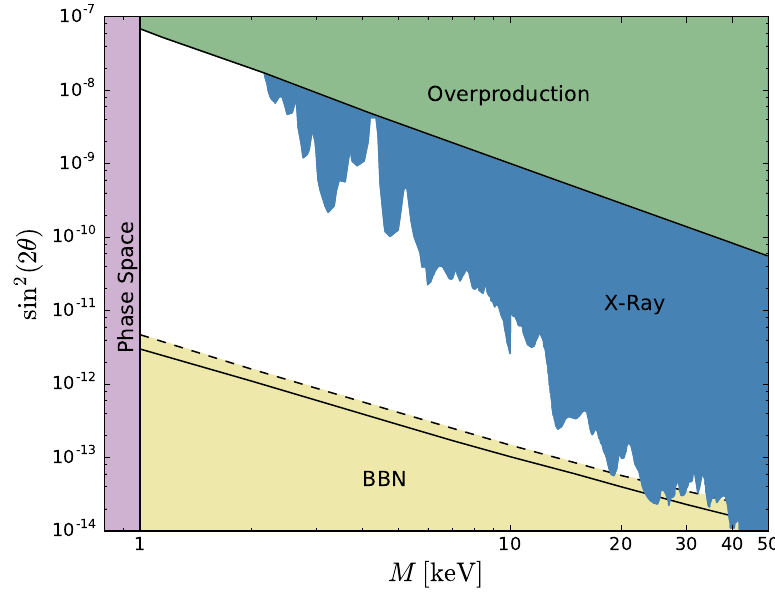
Figure 4 . Combined constraints for keV sterile-neutrino dark matter. The X-ray constraints are taken from [30], see also [10, 31{33]. Phase space density constraints are from [29]. The BBN limit given by the solid black line holds if all of the input lepton asymmetry is only in the muon (cid:13)avor. The dashed line corresponds to the BBN limit if the input lepton asymmetry is split equally onto all three